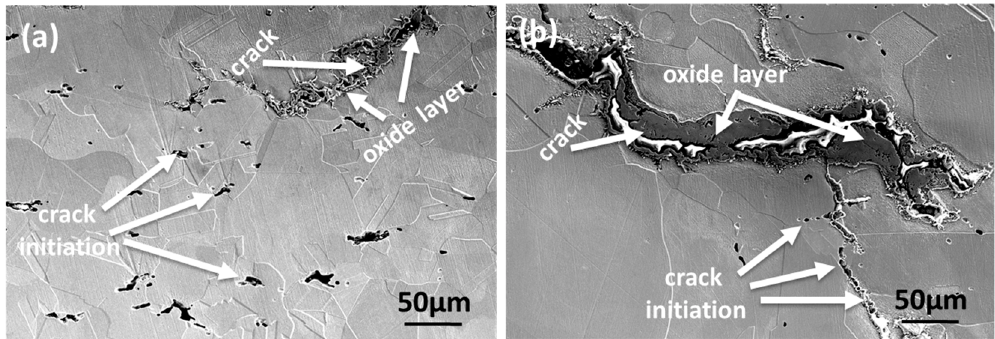
Figure 8. Surface morphologies of the specimens after thermal fatigue tests under different T max conditions: ( a ) 800 °C and ( b ) 900 °C.